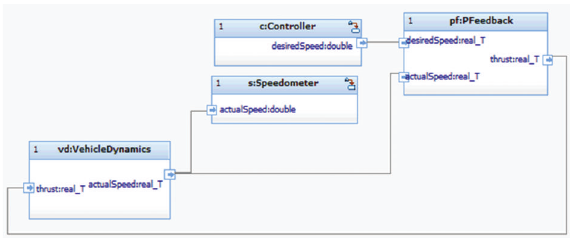
Figure 5: Internal block diagram of CruiseControlSystem block.